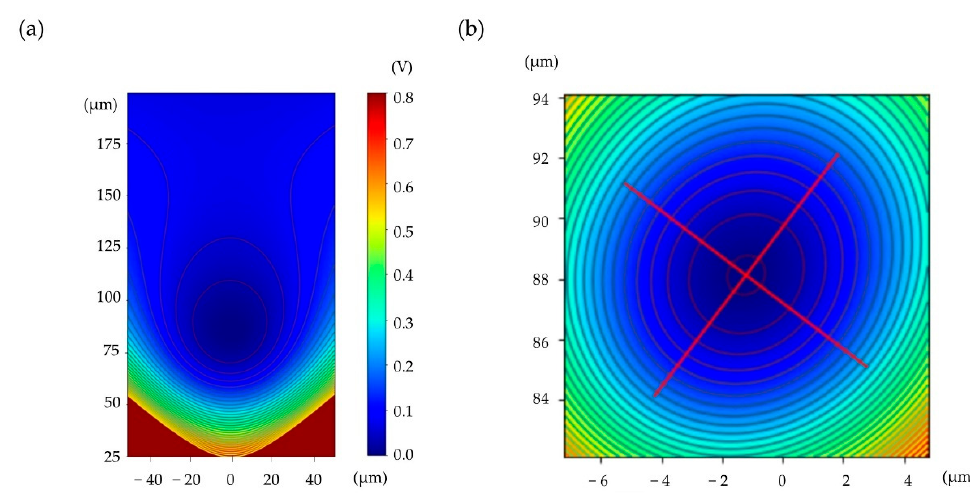
Figure 2. Comparison of the electrode layout of the entire surface ion trap chip and the numerical simulation. ( a ) Layout of the top layer electrodes in the surface trap used for the measurement. ( b ) Dimension of the electrodes near the trapping region (not drawn to scale) and the DC voltages used in our simulation. Inner DC electrodes are 14 µm below the RF and outer DC electrodes. The dashed red box indicates the electrode geometry used in the numerical simulation. Note that the red box shows only a small part of the entire chip.